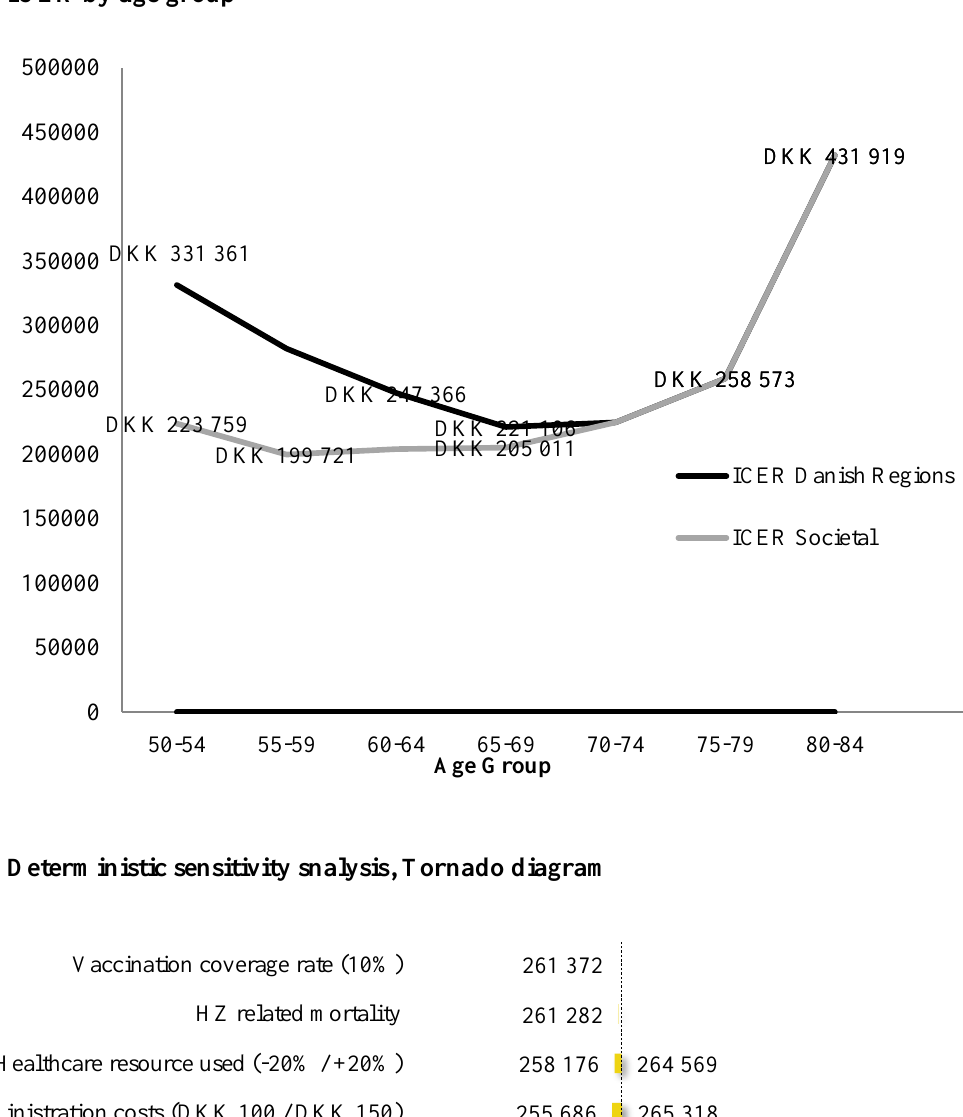
Figure 2: ICER by age group